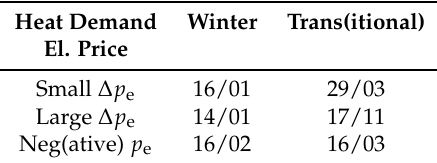
Table 1. The nine days selected for the GenkNET case. These days will be referred to as <season>_<electricity